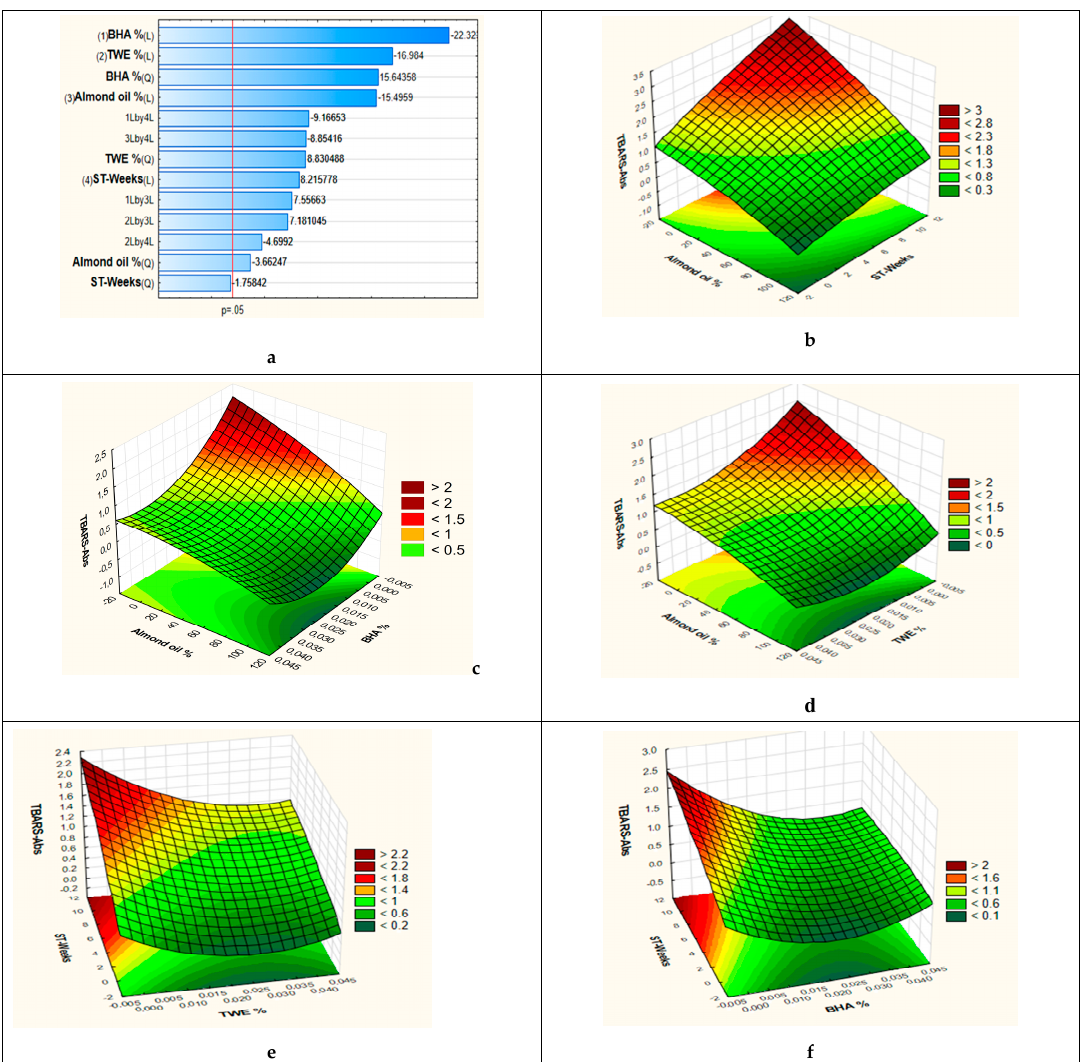
Figure 4(a) : Pareto chart showing the effects of the significant model coefficients. (b) : Response surface plot showing the combined effect of storage time and emulsion almond oil %. (c) : Response surface plot showing the combined effect of BHA concentration and emulsion almond oil %. (d): Response surface plot showing the combined effect of thyme extract concentration and emulsion almond oil %. (e) : Response surface plot showing the combined effect of thyme extract concentration and storage time.( f) : Response surface plot showing the combined effect of BHA concentration and storage time. TWE: Thyme waste extract; ST: storage time.